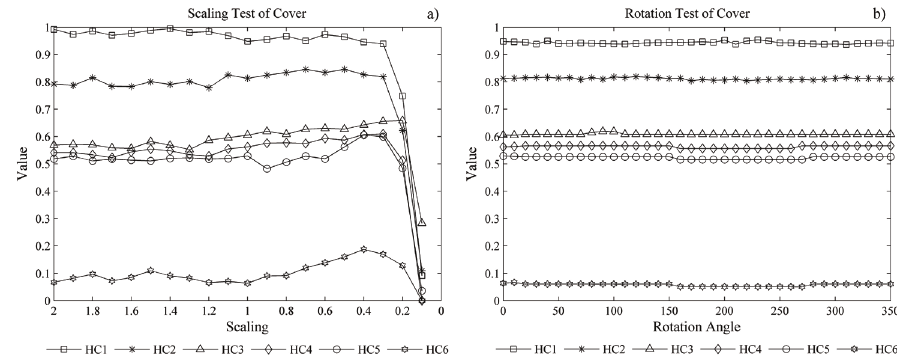
Figure 4. Tests of Cover with various hydrophobic levels. a) Scale transformation, b) Rotationtransformation.